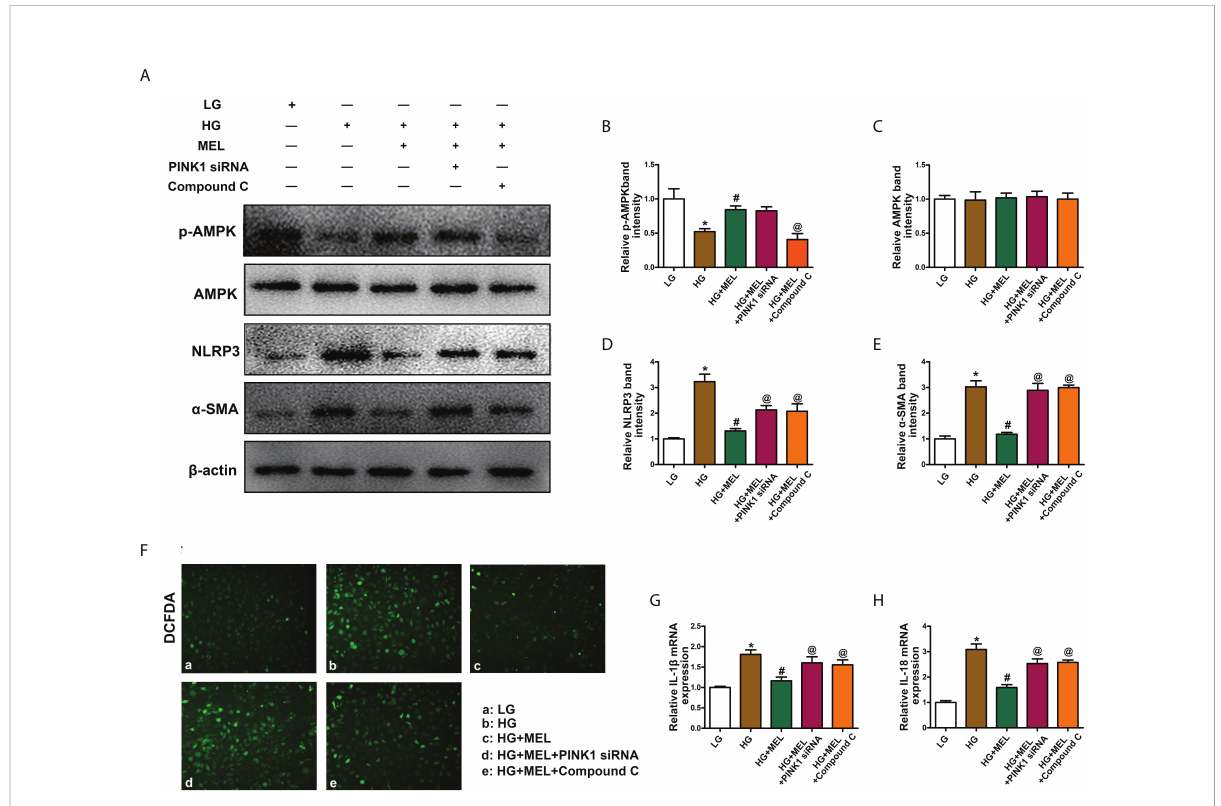
FIGURE 6 The effect of metformin on oxidative stress, in fl ammation, and fi brosis in HK-2 cells treated with HG. Western blot analysis of p-AMPK (A, B) , AMPK (A, C) , NLRP3 (A, D) , and SMA (A, E) expression. DCFDA staining was used to detect intracellular oxidative stress (F) . The mRNA levels of IL-1 b (G) and IL-18 (H) in the different groups. The values are the mean ± SD. n = 4/group. *p < 0.05 compared with the control group; # p < 0.05 compared with the HG group. @ p < 0.05 compared with the HG+MEL